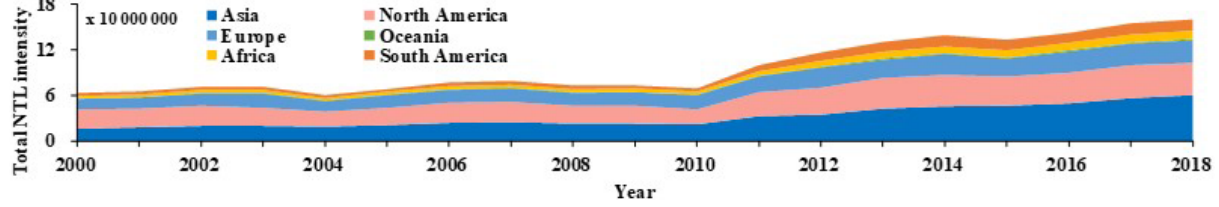
Figure 10. The dynamics of total NTL intensity from 2000 to 2018 in each continent.